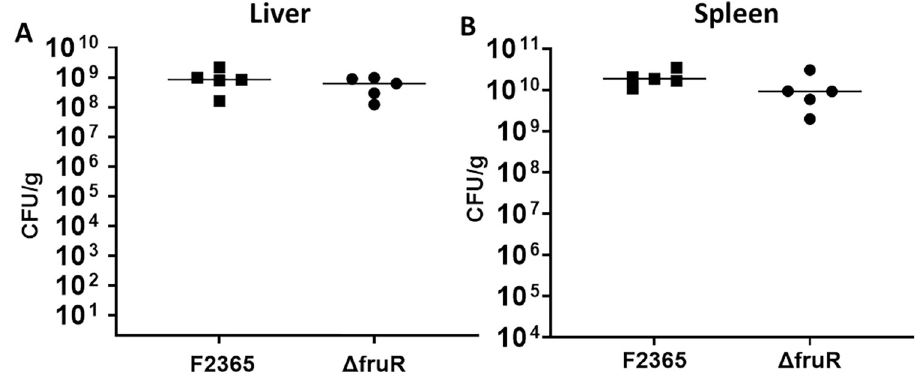
Fig 6. The contribution of FruR to neutrophil/monocytes resistance. The Δ fruR strain has similar virulence as wildtype strain in mice depleted of neutrophils/monocytes. Mice (5 mice per cage) were injected IV with monoclonal antibody RB6 at 24 and 6 hours before experimental infection. Livers and spleens were harvested at 72 hours post- infection. There was no significant difference in CFU observed between Δ fruR strain and wildtype.